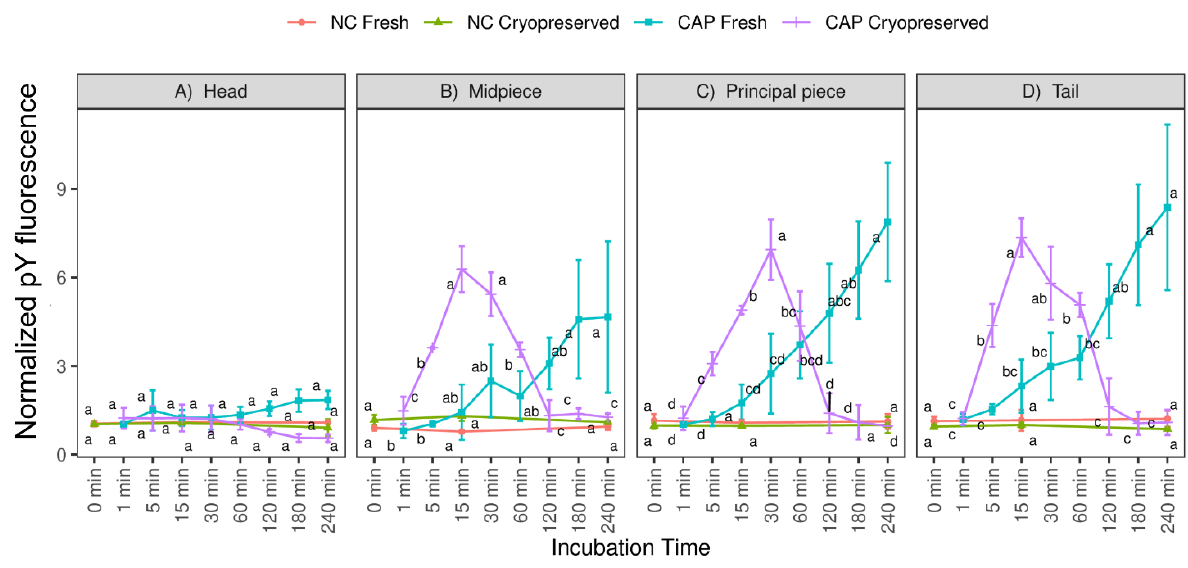
Figure 3. Protein tyrosine phosphorylation (pY) in different sperm regions throughout incubation of fresh and frozen- thawed ram spermatozoa in capacitating (CAP) and non-capacitating (NC) media (n = 12 ejaculates, 4 rams × 3 replicates). The sperm regions evaluated were ( A ) head (includes sperm with fluorescence in the entire head, acrosome or equatorial segment), ( B ) midpiece, ( C ) principal piece and ( D ) tail (includes spermatozoa with fluorescence in the midpiece and principal piece). The mean fluorescence intensity of all spermatozoa in each region and time was normalized to the mean fluorescence intensity of the same region at 0 min NC (±S.E.M). Different letters denote substantial changes ( p < 0.05) among incubation times within each type of sample.